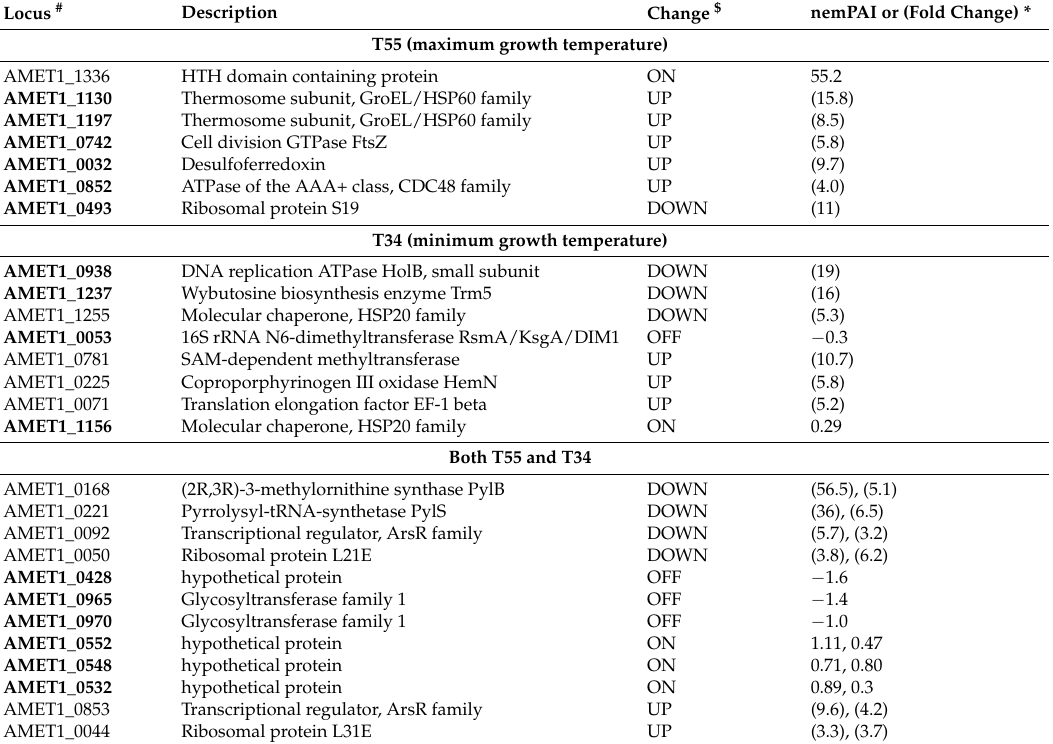
Table 2. Selected proteins involved in temperature change response in M. thermophilum AMET1. Locus